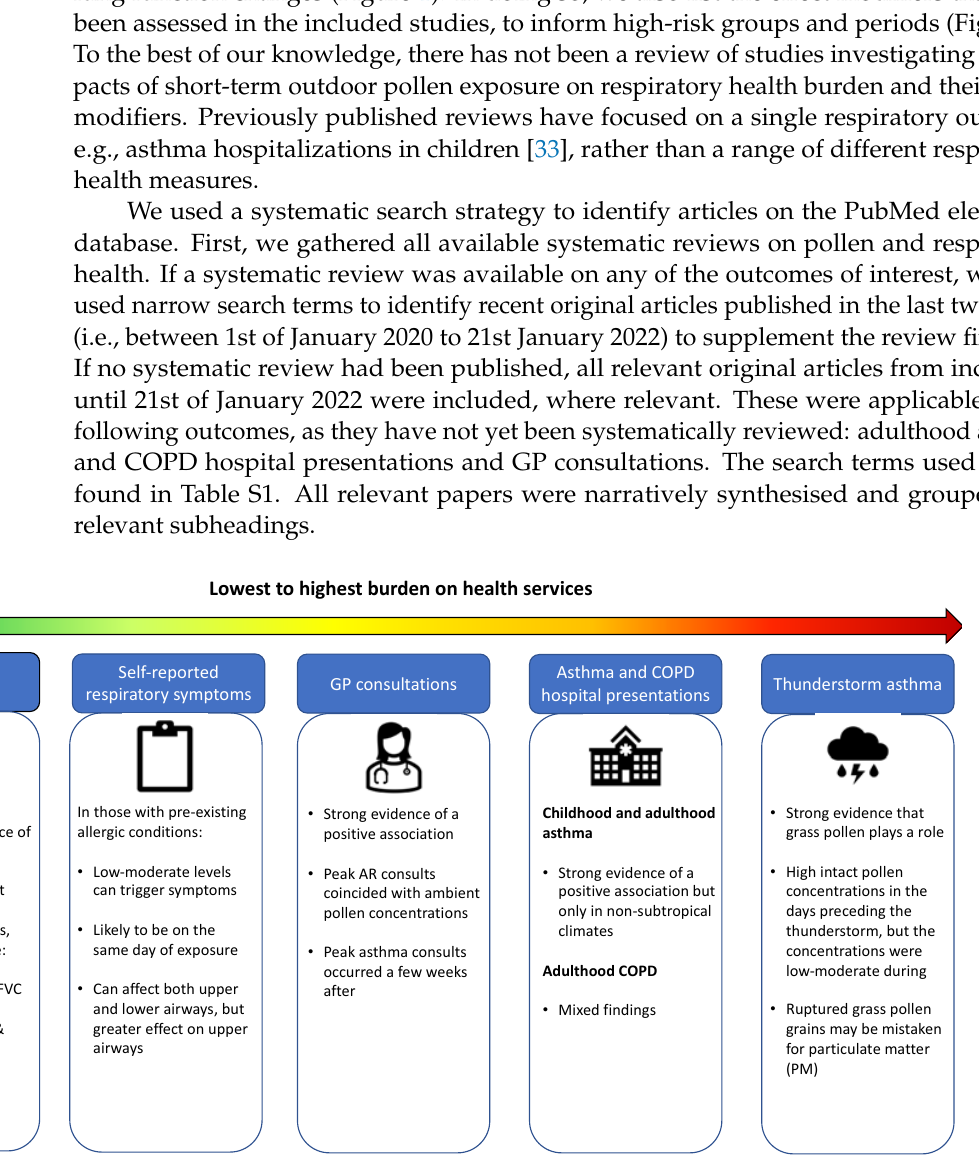
Figure 1. Summary of findings on the short-term impact of ambient pollen on respiratory outcomes (lowest to highest burden on health services).